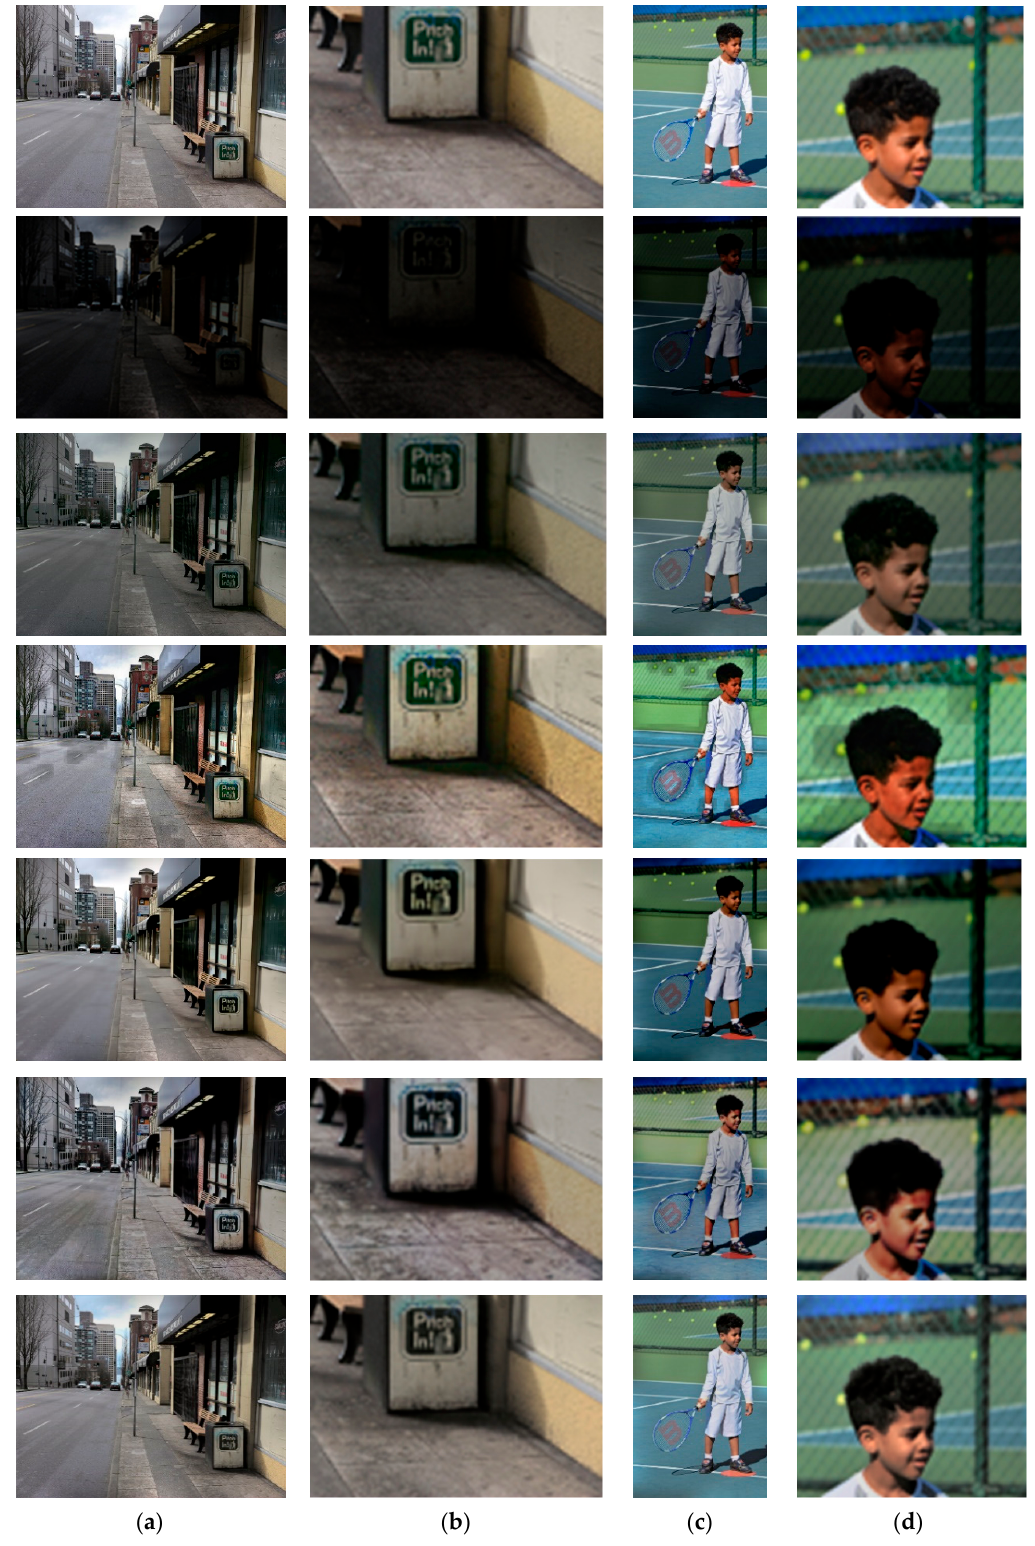
Figure 5. Visual comparisons of with-ground-truth images: (from top to bottom) ground-truth image, degraded image, MSR-net, retinex-net, MBLLEN, KinD, and proposed method. ( a ) test image1, ( b ) partially zoomed-in view of ( a ), ( c ) test image2, and ( d ) partially zoomed-in view of ( c ).